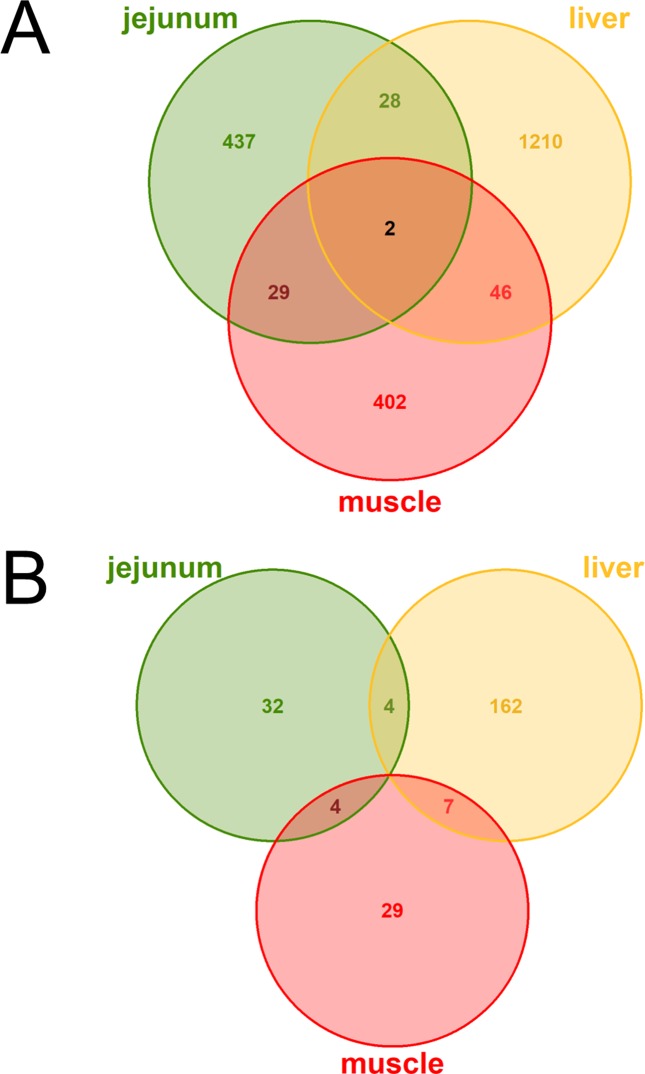
Venn diagrams of (A) all loci (B) exclusively lncRNAs with differential expression (DE) between high and low metabolic efficiency in cattle. DE analysis was performed within the tissues jejunum, liver, muscle, and rumen. No loci were significantly [q-value (Benjamini–Hochberg) < 0.05] DE in rumen.